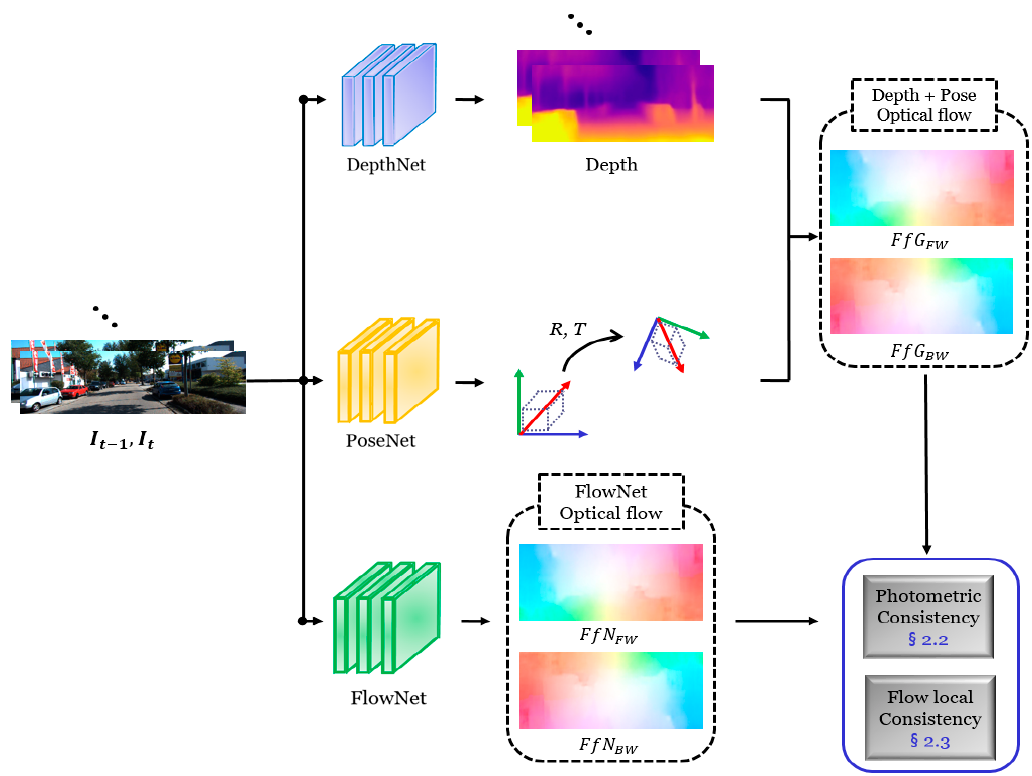
Figure 2. Flow prediction framework. The proposed architecture consists of two main parts: geometrical flow and network flow for the cross-check of the flow.